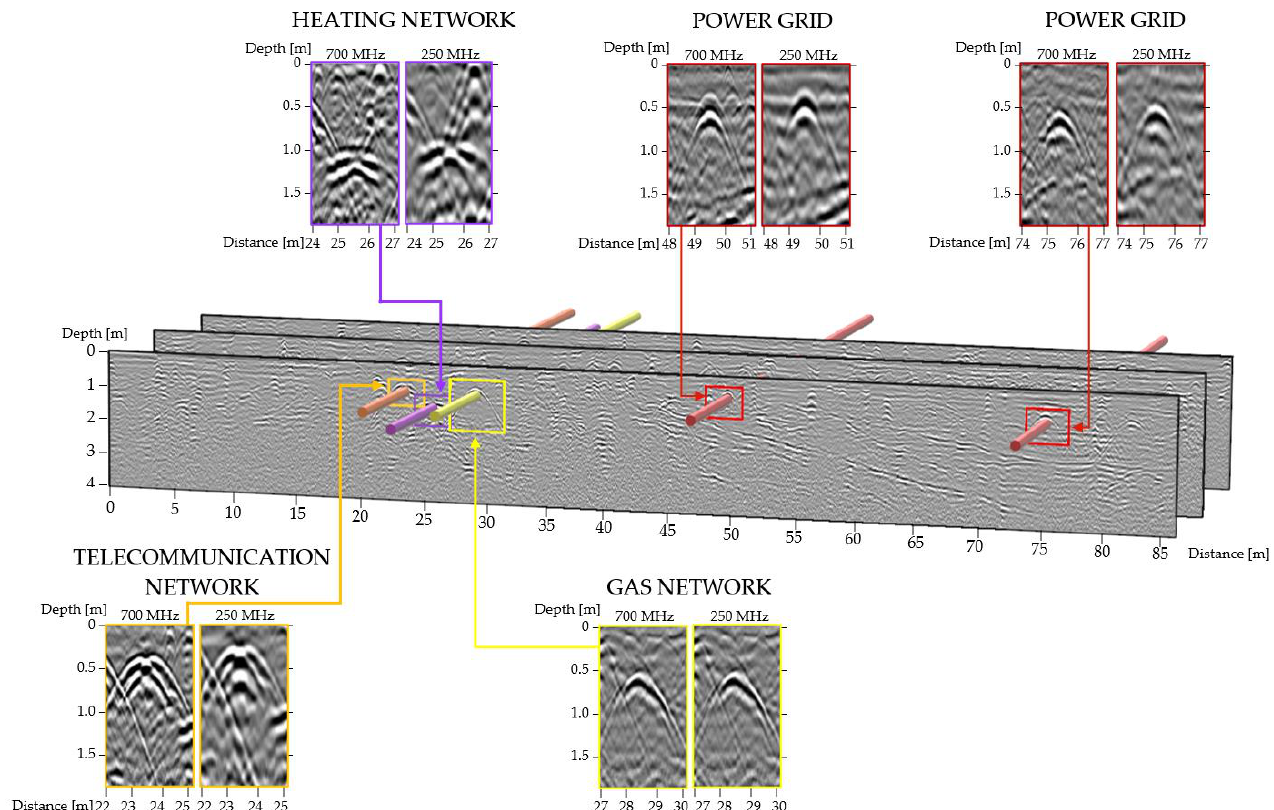
Figure 3. Schematic view of the detected underground infrastructure in front of the radargram. The final stage of data processing relied on comparing the coordinates of characteristic points of the detected networks with their reference data obtained from the National Geodetic and Cartographic Resource [48]. The purpose of this comparison was to verify the manually selected points by reference-to-reference